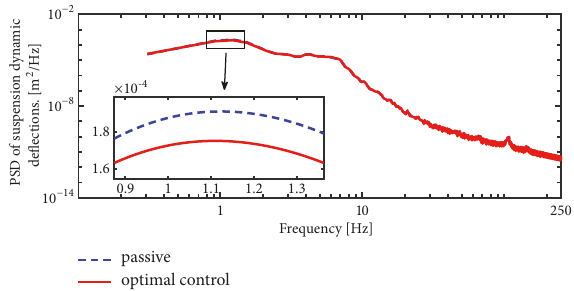
Figure 14: Frequency response of suspension dynamic deflections.